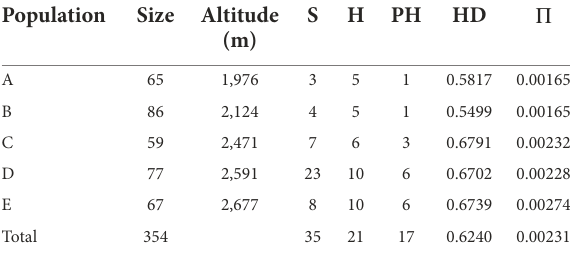
TABLE 1 Sample size, and genetic variation of Phytophthora infestans Pi02860 sequences collected from five altitudinal locations.